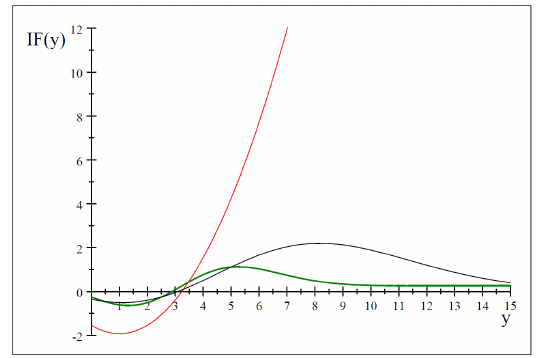
Figure 1. Influence function of the MDPDGE for the exponential model with τ = 0 (red), τ = 0.2 (black) and τ = 0.8